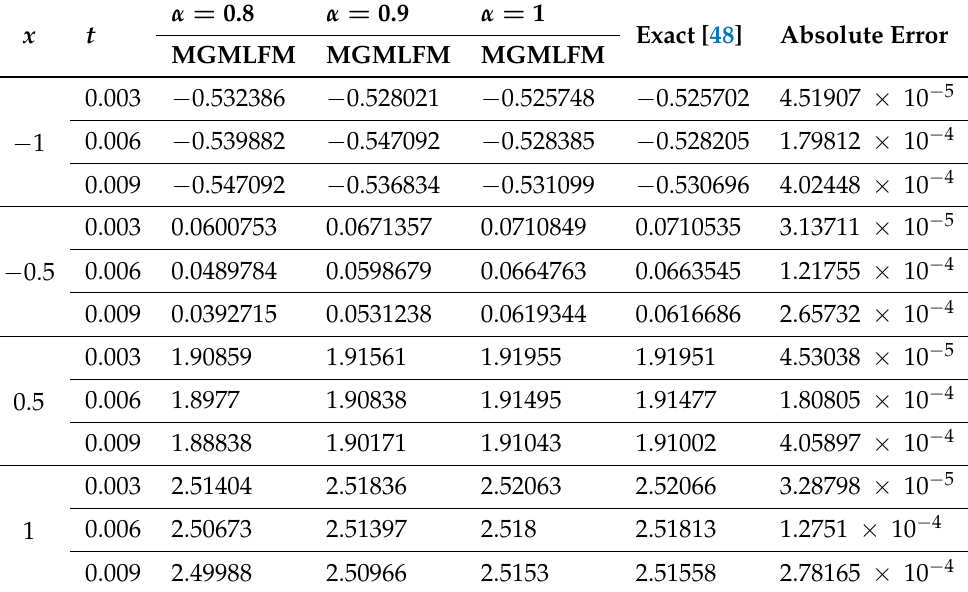
Table 1. Values of approximate solutions obtained by the MGMLFM, exact solution, and absolute errors of U ( x , t ) for system (1) with various values of α , t and x